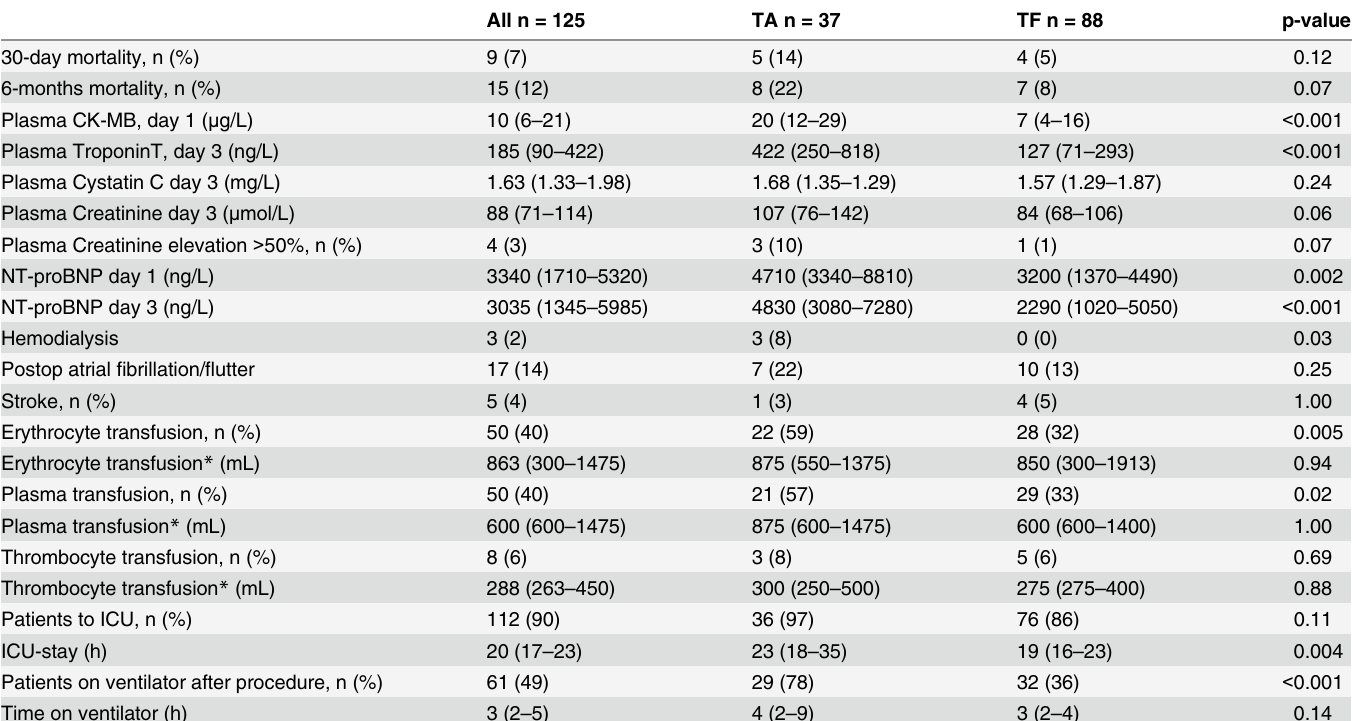
Table 2. Mortality and postprocedural in-hospital outcome measures.